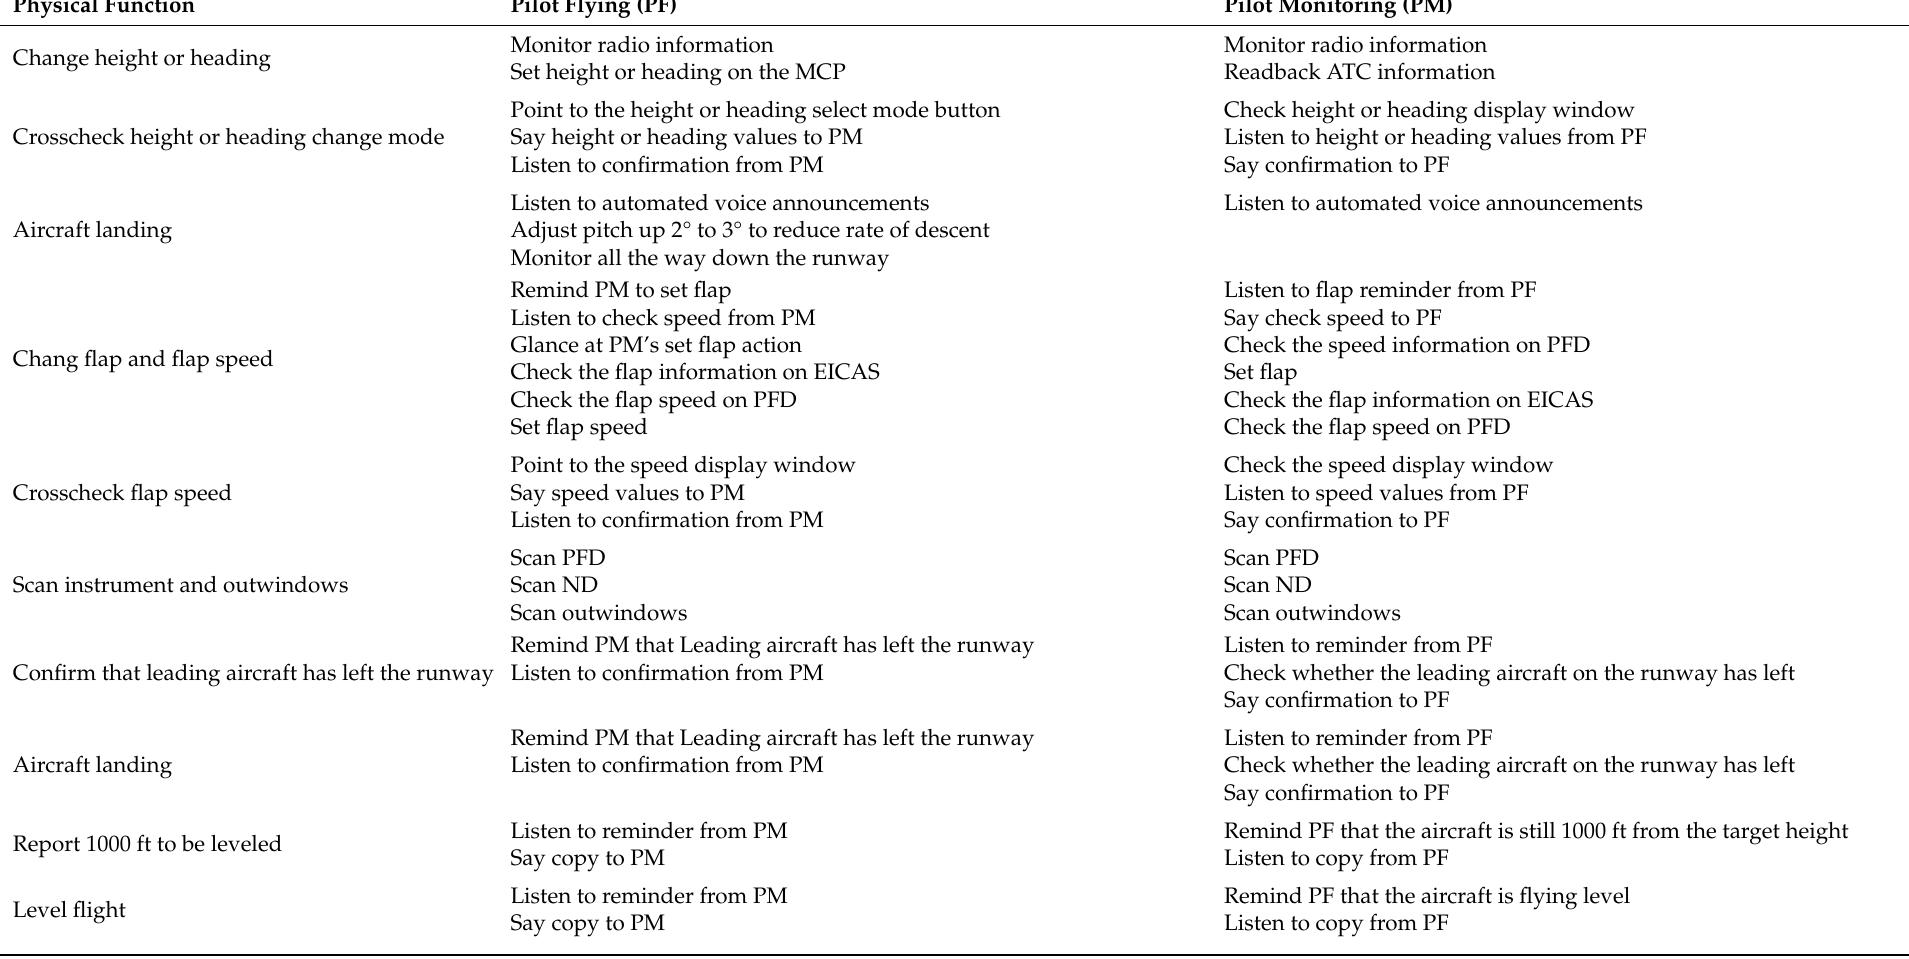
Table 1. Functions performed by the Pilot Flying (PF) and Pilot Monitoring (PM) in the current two-crew